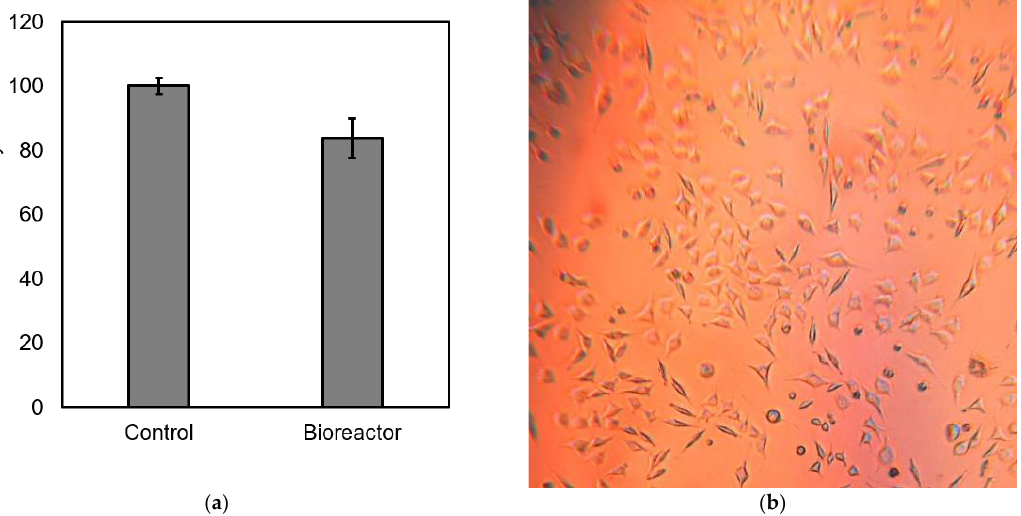
Figure 10. Cell viability of L929 incubated in the developed bioreactor: ( a ) percent cell viability obtained from MTT assay with respected to control group ( n = 6); ( b ) a microscopic image of cells after incubation in the bioreactor for 48 h.